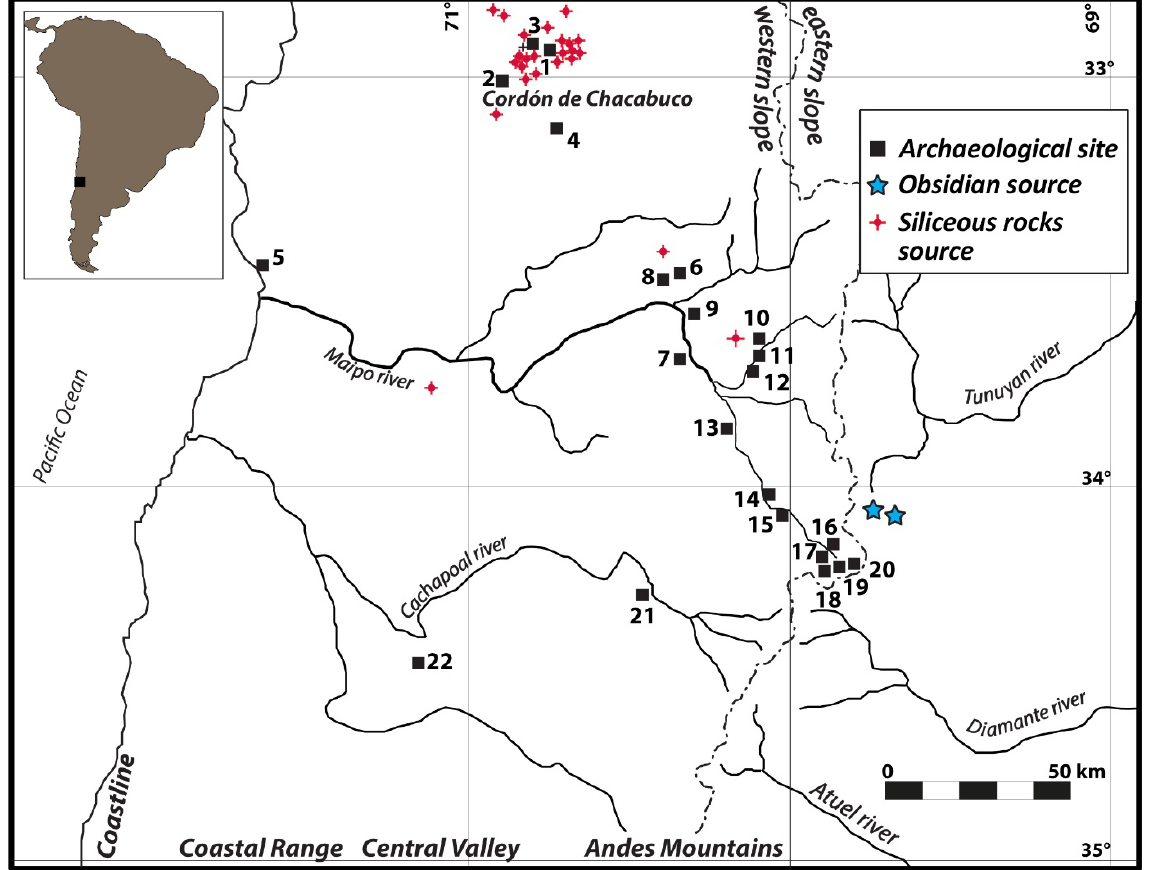
Figure 1. Study area showing the location of archaeological